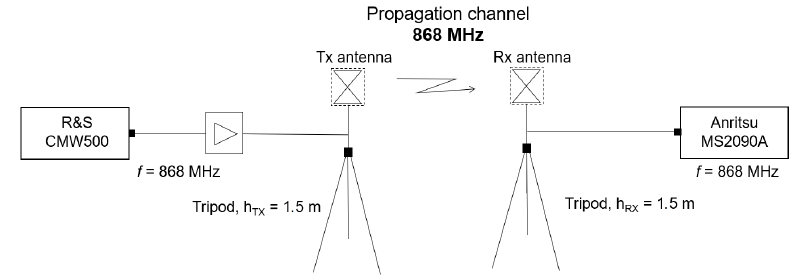
Figure 6. Measurement configuration with 5G